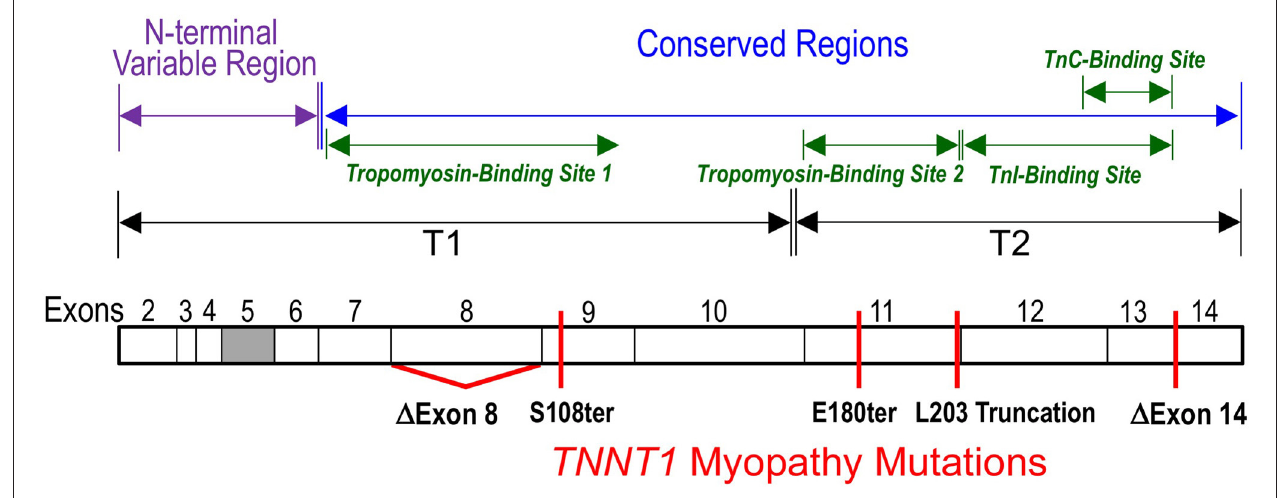
FIGURE 2 | Myopathic mutations of TNNT1 . Locations of the nonsense and splicing mutations found in TNNT1 gene that truncate the slow TnT polypeptide chain or causes an internal deletion are illustrated on a linear map of slow TnT protein with the segment encoded by exons 2-14 outlined. The filled box indicates alternatively spliced exon 5. All of the five TNNT1 mutations cause recessively inherited nemaline myopathies. The known binding sites for TnI, TnC and tropomyosin are outlined.